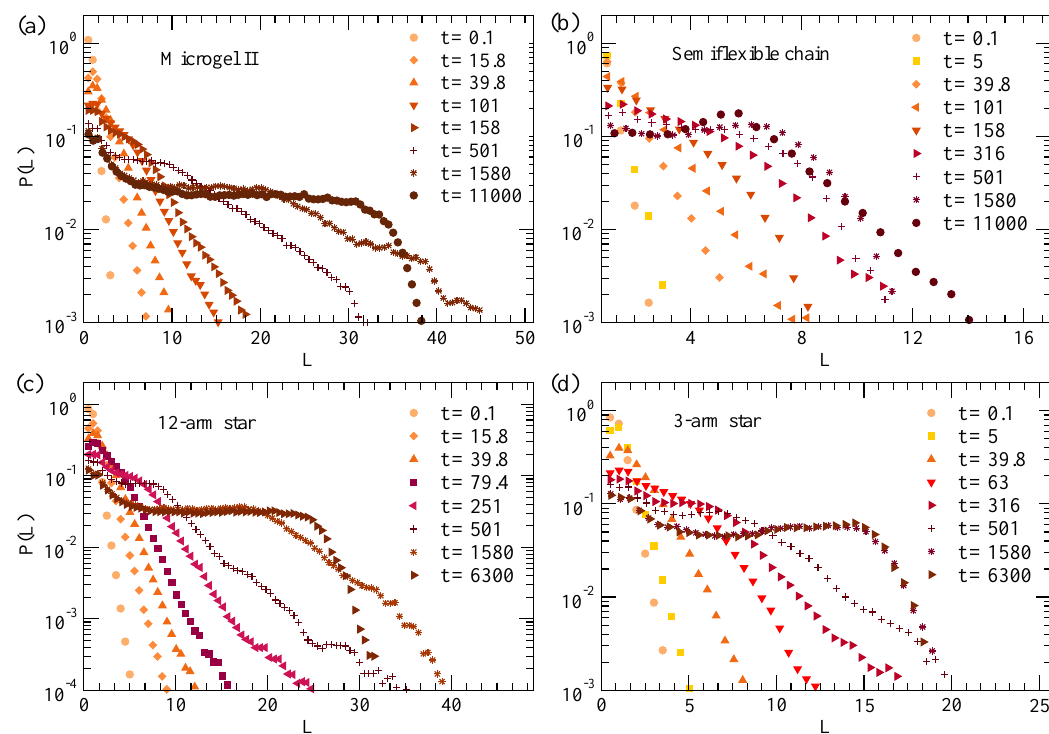
Figure 2. Normalized distribution of chord lengths at φ = 1.2 and different times during the collapse of the disordered microgel of middle asphericity ( a ), the semiflexible chain ( b ), 12-arm star ( c ) and three-arm star ( d ). The chord lengths are calculated for a density field with r c = 1.0 and ρ min =